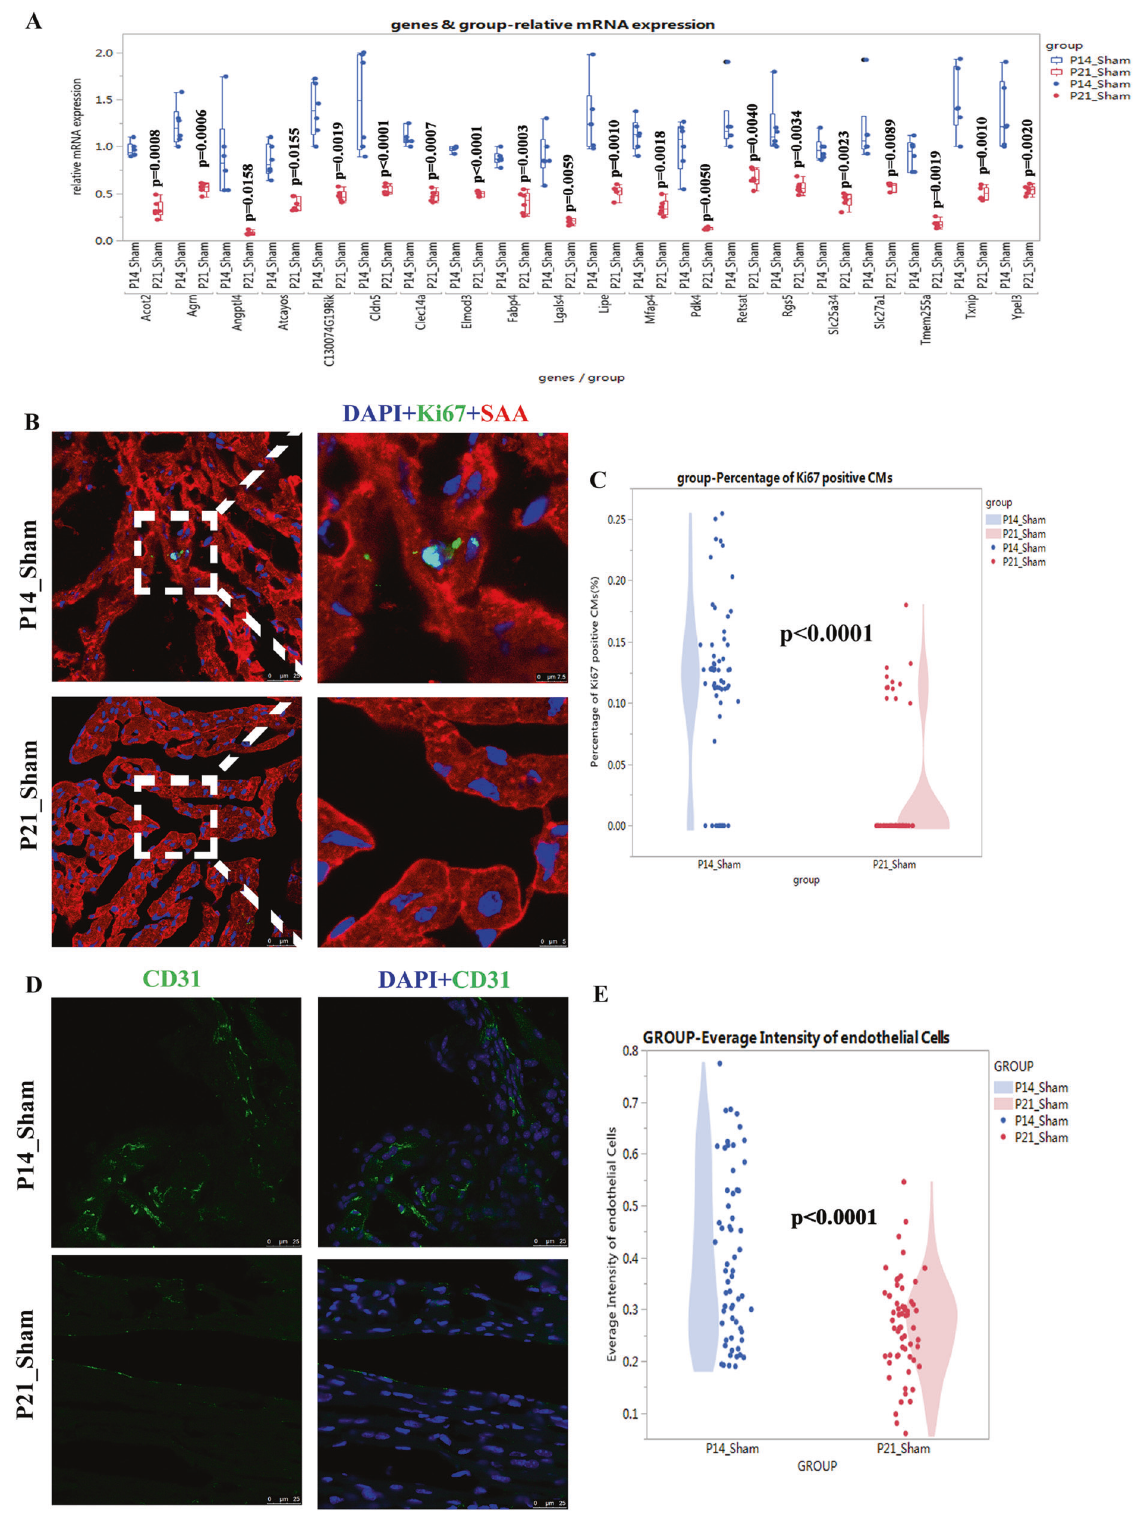
Fig. 6 Veri fi cation of downregulated processes during postnatal RV development. A The 20 genes manifesting the greatest fold changes of the downregulated transcriptome. B Representative Ki67-positive cardiomyocytes in the sham group. C Quanti fi cation of Ki67-positive cardiomyocytes in the sham group ( N = 60 slides from six mice). D Representative CD31-positive cells in the sham group. E Quanti fi cation of the average intensity of endothelial cells ( N = 60 slides from six